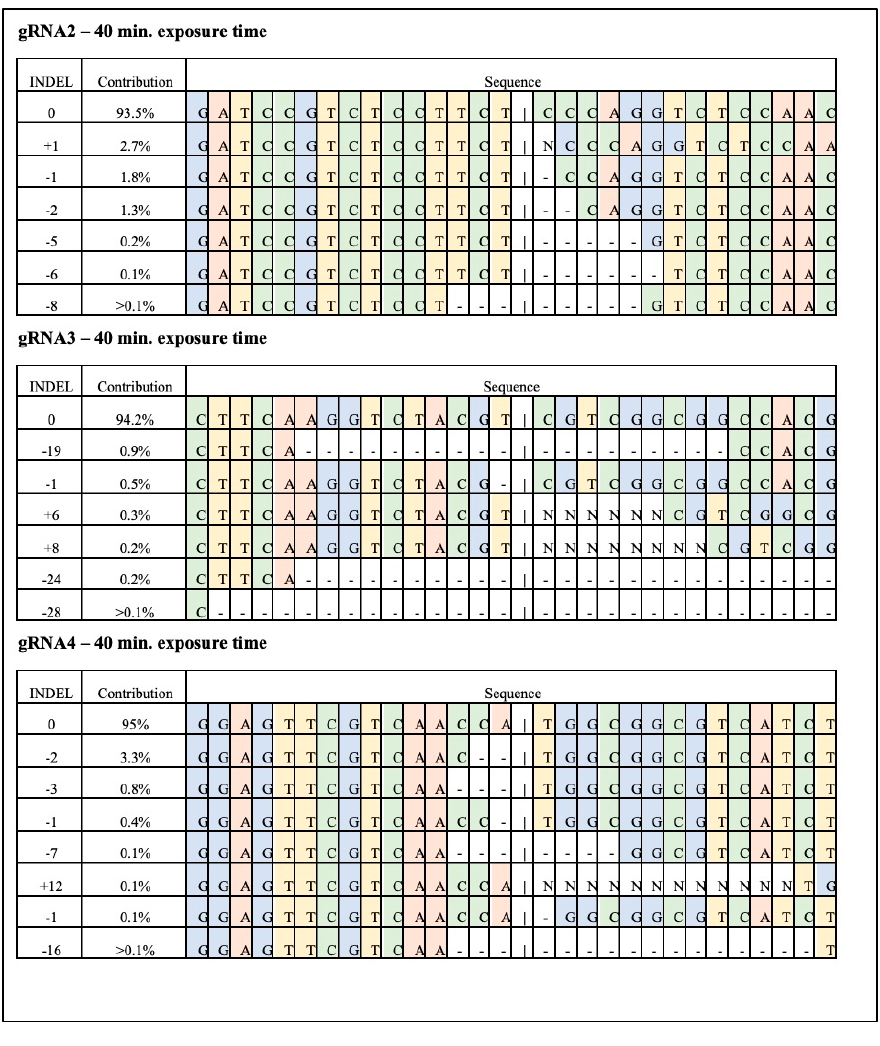
Figure 5. Sequence distribution of most efficient mutations identified with the ICE software around the IPK gene target site in Zea mays . Edited sequences were obtained after CRISPR-Cas9 RNP transfection to maize protoplasts. Forty-five μ g of Cas9 preassembled with 15 μ g of each gRNA were used in the protoplast transformation. Different exposure times of the RNP complex with the protoplast are presented. Cut sites are represented by black vertical dotted lines, insertions are represented by ‘N’ and deletions by black horizontal dotted lines.